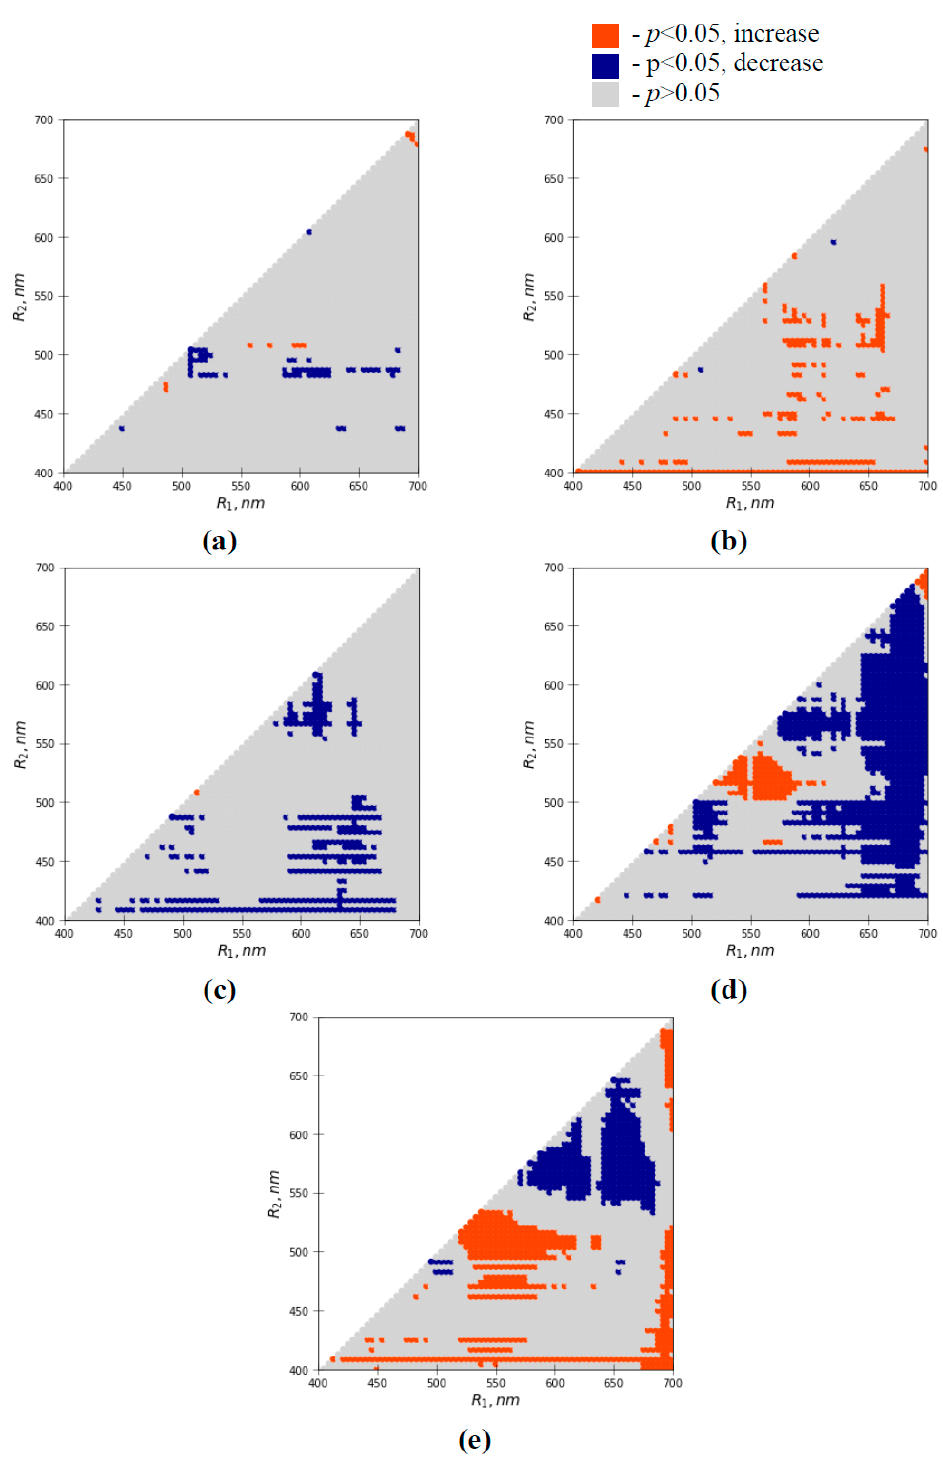
Figure 4. Heatmaps of significances and directions of water shortage-induced changes in ∆ RIs in pea leaves in the first ( a ), second ( b ), third ( c ), fourth ( d ), and fifth ( e ) days of the water shortage. RIs were calculated based on equation ( R 1 ) − I ( R 2 ) RI = I , where I(R 1 ) and I(R 2 ) are intensities of reflected light at different narrow spectral bands (averaged for 3 nm). I ( R 1 )+ I ( R 2 ) ∆ RI (the light-induced change in RI) was calculated as RI − RI 2 1 . RI 1 was calculated based on I(R 1 ) and I(R 2 ) measured immediately after turning on the halogen lamp (first time point), and RI 2 based on I(R 1 ) and I(R 2 ) measured 7 min after turning on lamp (second time point). The Mann–Whitney U test was used for p